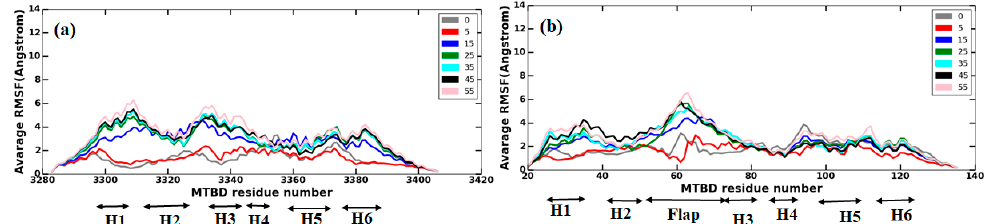
Figure 7. Root-mean-square fluctuation (RMSF) of MTBDs’ residues when MTBDs are located in different distances. Panels ( a , b ) show the average RMSF of three independent runs for each residue of cytoplasmic and axonemal MTBDs, respectively.